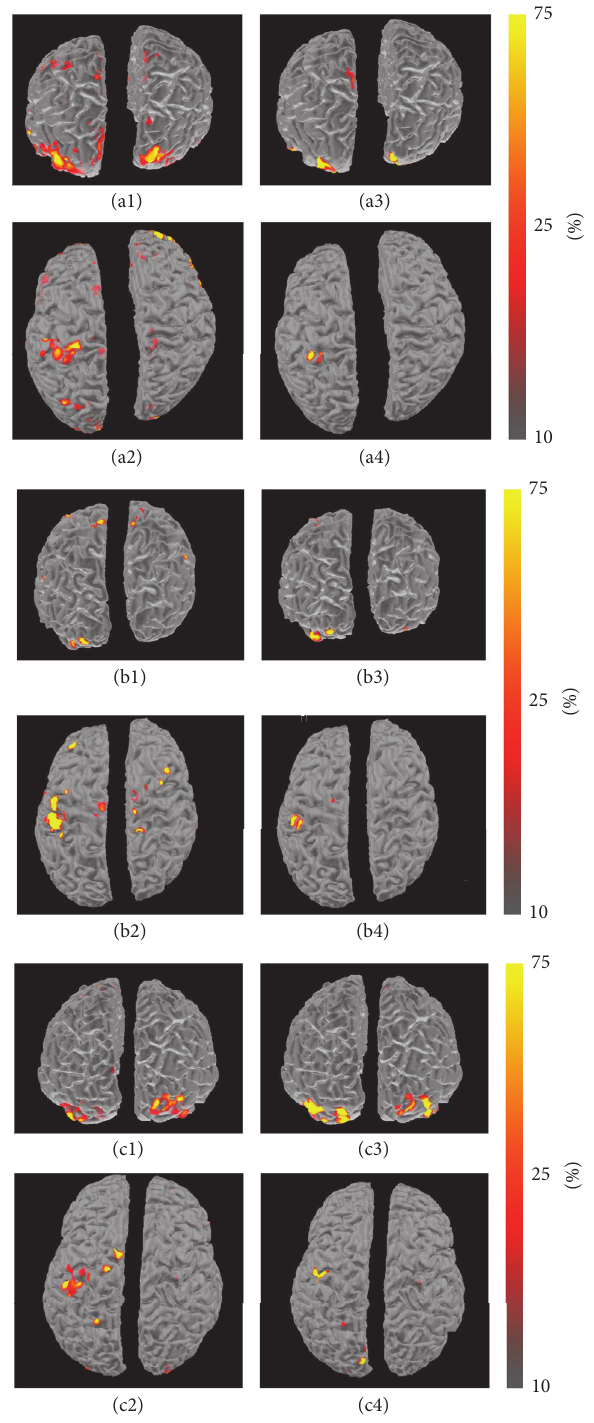
Figure 5: Source imaging results comparing two EEG/fMRI inte- gration approaches: time-invariant fMRI constraints ((a1), (a2); (b1), (b2); (c1), (c2)) and spatiotemporal fMRI constraints ((a3), (a4); (b3), (b4); (c3), (c4)) at two time instances to demonstrate visual activation((a1),(a3);(b1),(b3);(c1),(c3))andmotoractivation((a2), (a4); (b2), (b4); (c2), (c4)). Source activity shown is color coded as a percentage of its